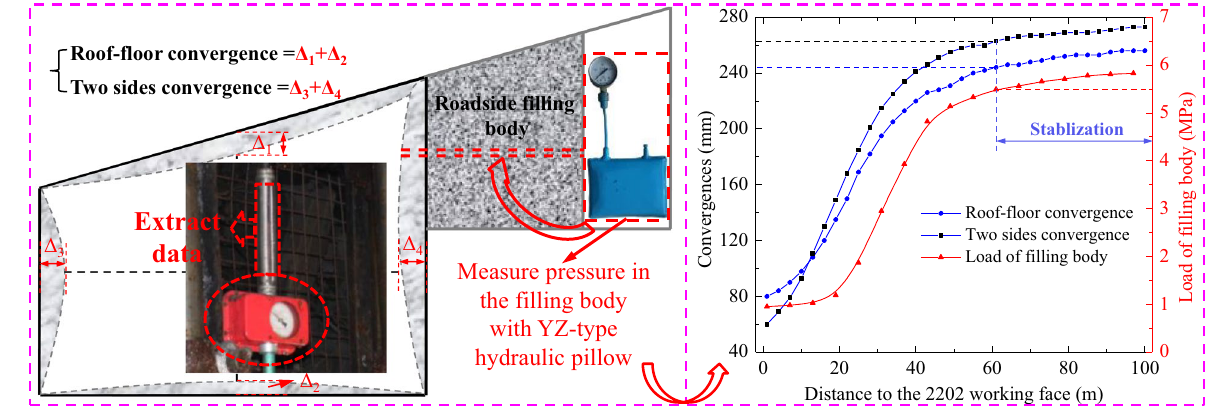
Fig. 15 Mine pressure curves of 2202